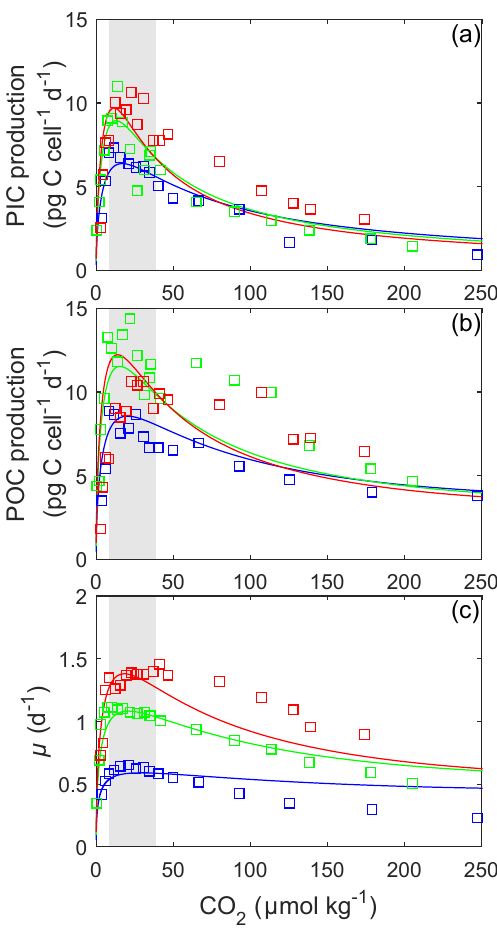
Figure 1. (a) Fitted PIC, (b) POC production and (c) growth rates (solid lines) of E. huxleyi in response to changes in carbonate chem- istry at 10, 15 and 20 ◦ C using Eq. (2) and fit coefficients from Ta- ble 1. Symbols represent rate measurements from Sett et al. (2014) at 10, 15 and 20 ◦ C and 150µmolphotonsm − 2 s − 1 . Shaded areas represent modern ocean CO 2 concentrations of 8.5–30µmolkg − 1 based on data from Takahashi et al. (2014).